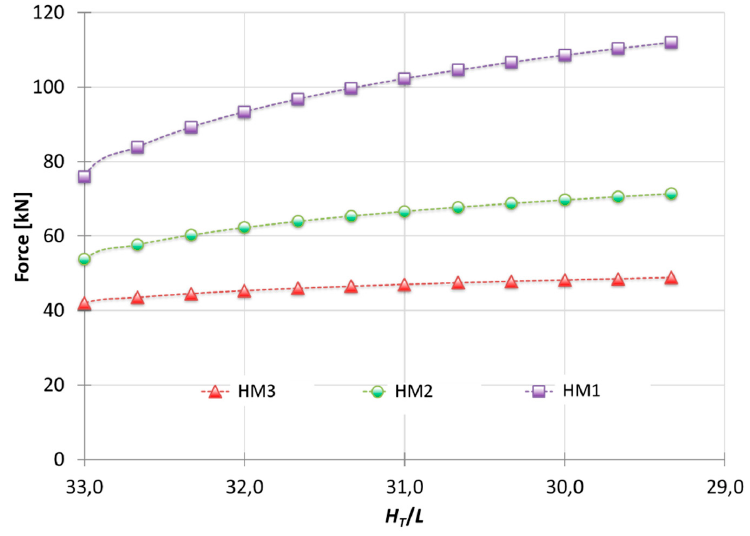
Figure 7. Results for Aluminum A92030 when the different Hardening Models apply.